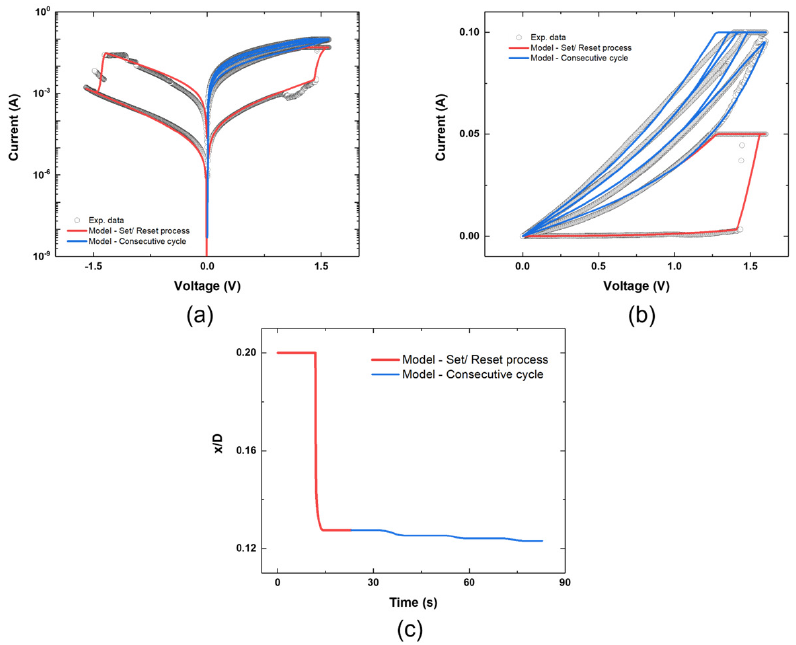
Figure 3. ( a ) Electrical characteristics of the Pt/Ti/TiO x /Al 2 O 3 /Pt/Ti device in logscale with the uni- fied model (Sweeping rate = 0.16 V/s), ( b ) Electrical characteristics of the Pt/Ti/TiO x /Al 2 O 3 /Pt/Ti device in linear scales with the unified model (Sweeping rate = 0.16 V/s), ( c ) Variation of x/D during the repetitive resistive switching operation represented in Figure 3b.